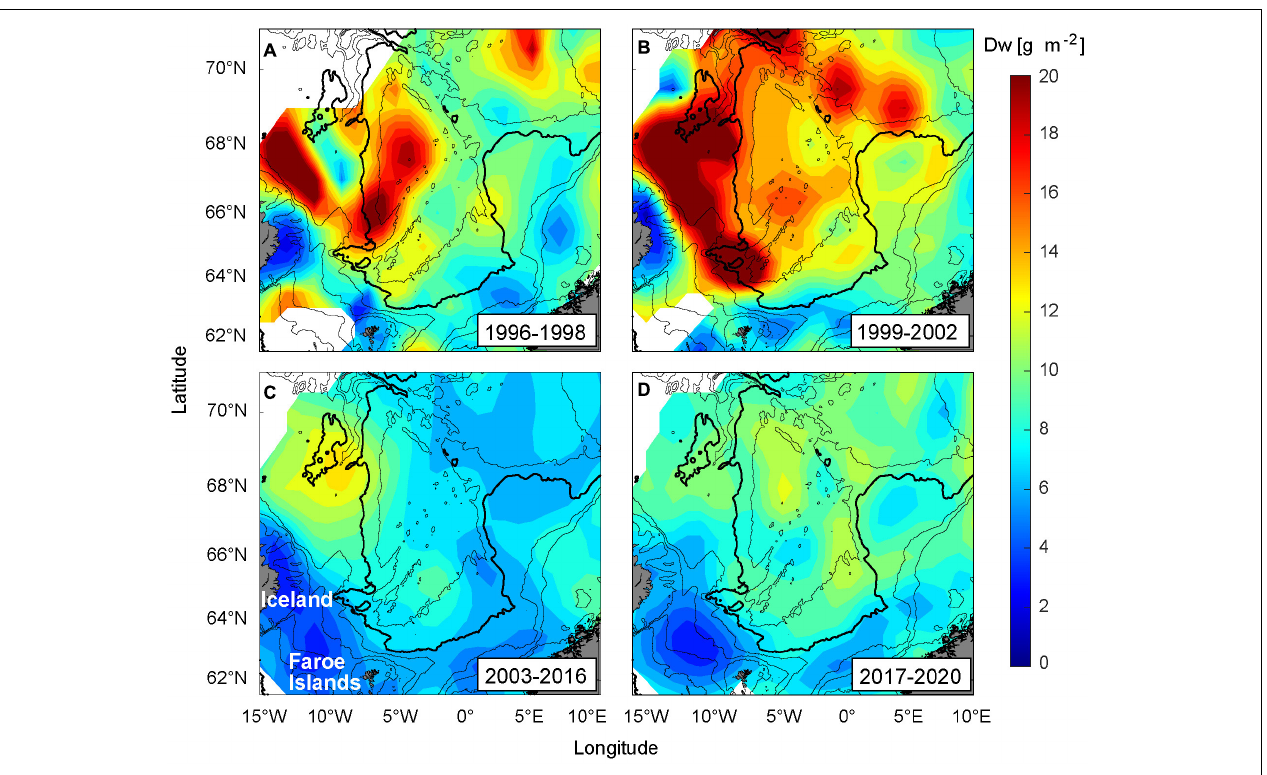
FIGURE 7 | Biomass of zooplankton (dry weight, Dw) distribution in May, averaged over the upper 200 m, and divided into the following four periods. (A) 1996–1998, (B) 1999–2002, (C) 2003–2016, and (D) 2017–2020. The 200, 500, 1,000, 2,000 (bold), and 3,000 m depth contours are shown. TABLE 2 | Overview over relevant parameters for assessing the posed hypotheses during the four contrasting periods.